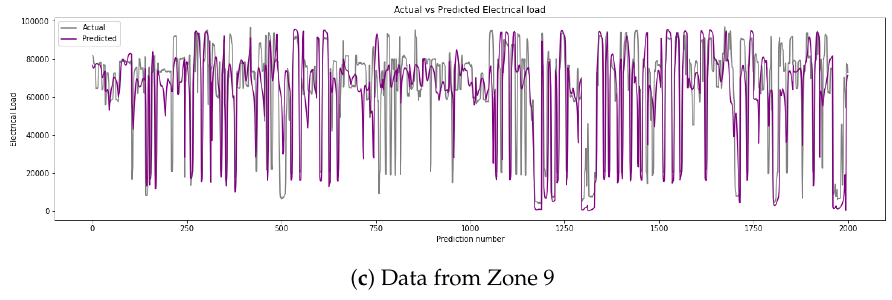
Figure 13. Usage data of different streams over time.